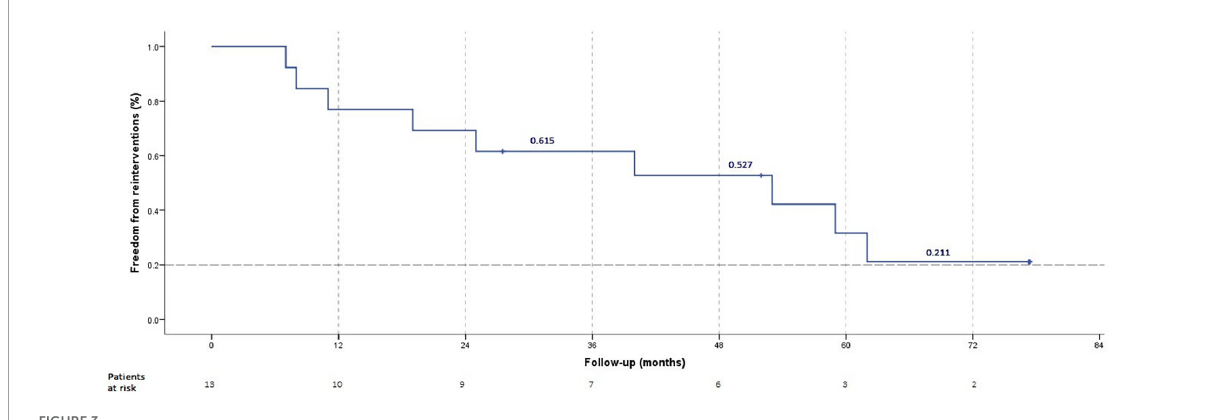
FIGURE3 Freedom from